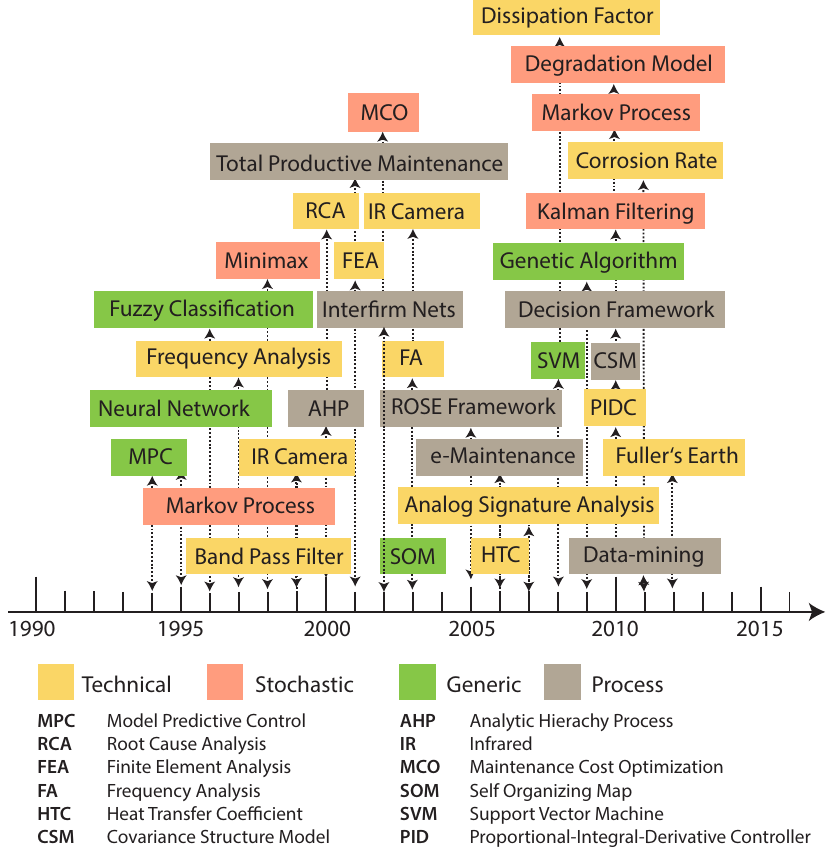
Figure 13. Timeline of